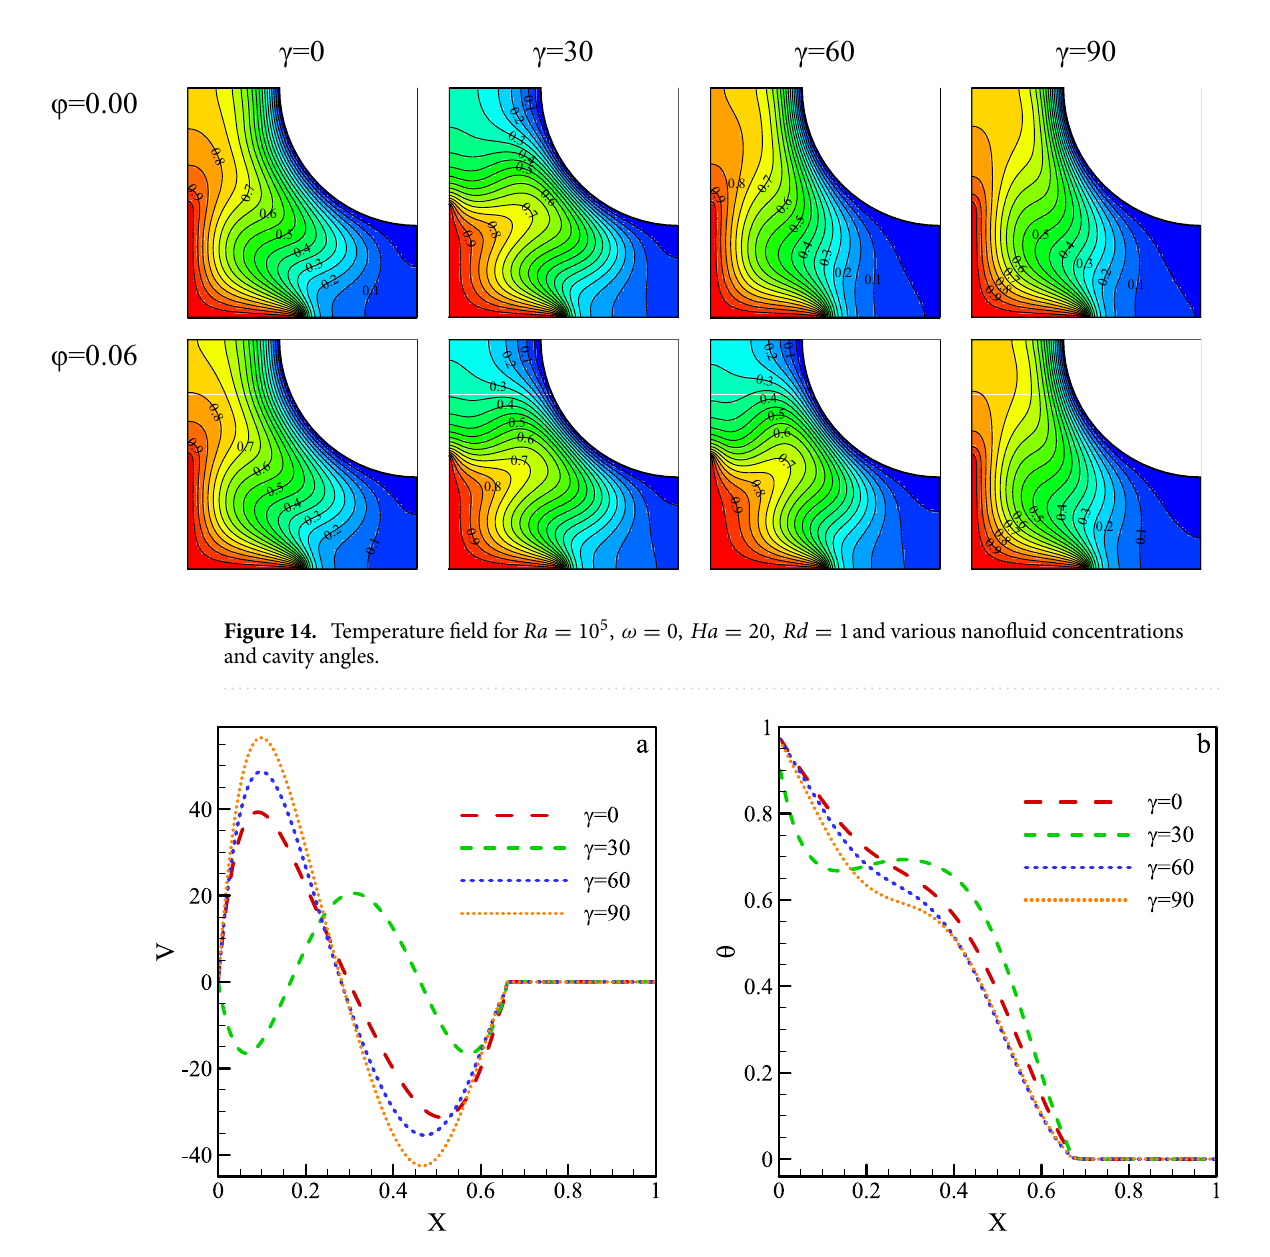
Figure 15. Variations of dimensionless ( a ) velocity and ( b ) temperature on line Y = 0.5 for Ra = 10 5 , ω = 0, Ha = 20, Rd = 1, ϕ = 0.03 and various cavity rises. The rise in the Nusselt number is dependent on the stream function value that represents the vortex veloc- ity. Higher vortex velocities improve the free convection heat transfer.